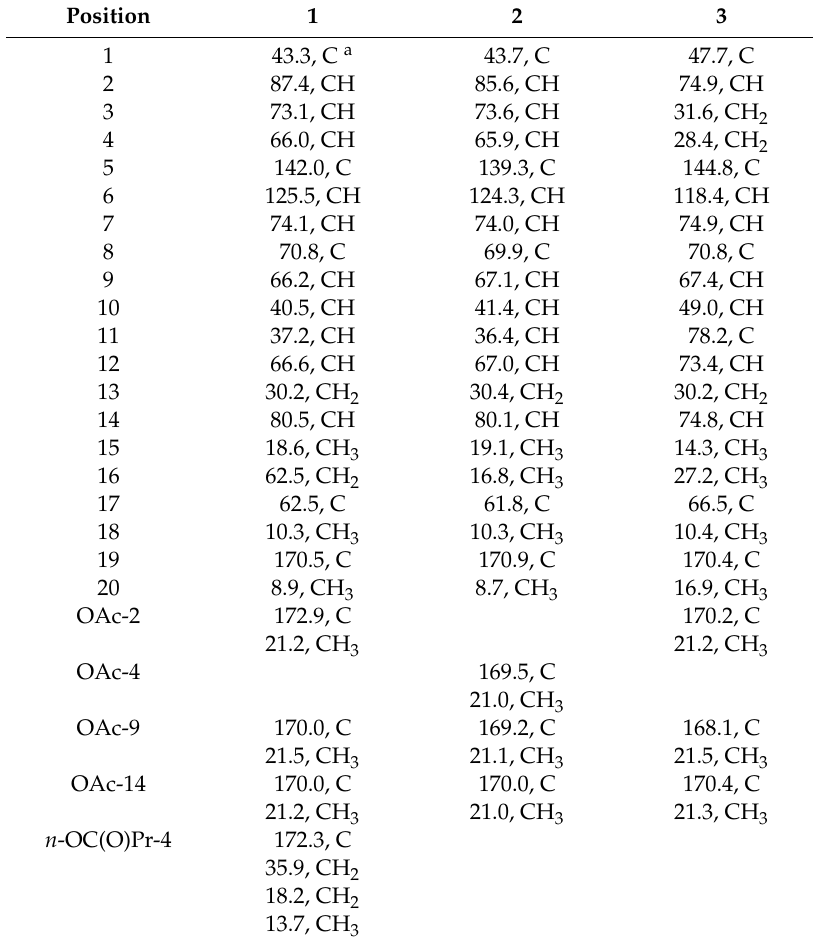
Table 1. 13 C NMR ( δ C 100 MHz, CDCl 3 ) data for briaranes 1 – 3 .